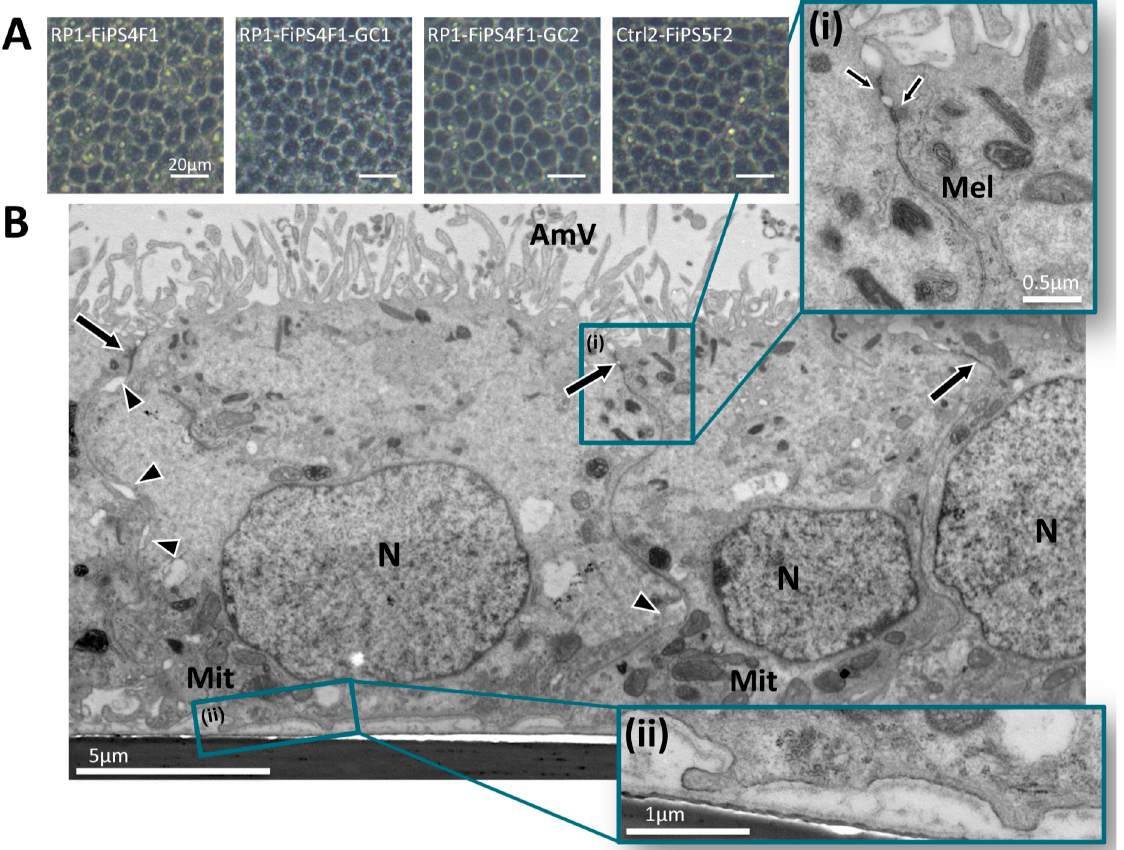
Figure 1. Differentiation of human-induced pluripotent stem cells (hiPSCs) into retinal pigment epithelium (RPE). ( A ) Representative brightfield micrograph of RPE derived from the four hiPSC lines employed in this study. All hiPSC-RPE show typical RPE polygonal morphology and pigmentation. ( B ) Representative electron micrograph of cultured RPE from the corrected hiPSC line (RP1-FiPS4F1-GC2). RPE form a monolayer of cuboid cells highly polarized with abundant apical microvilli (AmV) and melanosomes (Mel). The intercellular junctional complexes include apical tight junctions and adherens junctions (arrows), as well as membrane interdigitations (arrowheads). The nuclei and (N) and mitochondria (Mit) are located on the basal side of the cells. ( i ) High magnification shows melanin granules (Mel) and cell-cell junctions (arrows) ( ii ) High magnification of the basement membrane of the cells tightly bound to the transwells support film and small basal infoldings. Scale bars: A 20 µ m; B 5 µ m, ( i ) 0.5 µ m, ( ii ) 1 µ